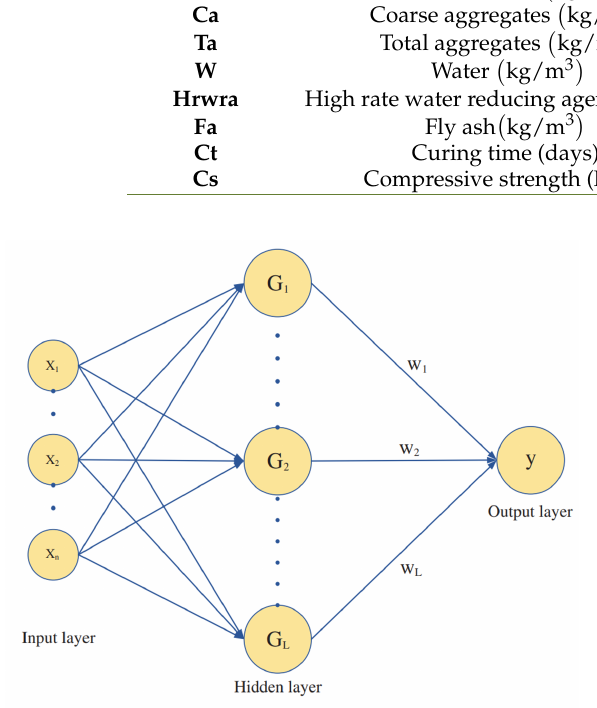
Fig. 1. RBFNN’s structure [48]